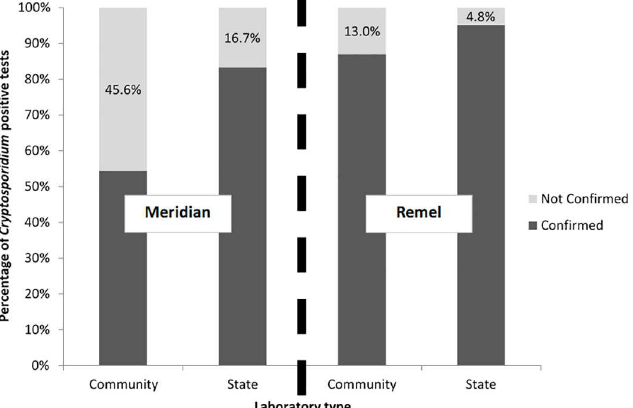
Fig 1. Comparison of positive predictive values for cryptosporidiosis rapid cartridge assay (RCA) tests performed in community laboratories and repeat testing under recommended conditions in state public health laboratories, by